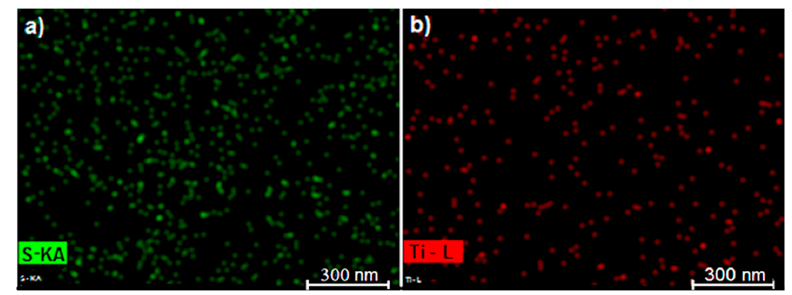
Figure 7. EDX maps for S ( a ) and Ti( b ) for a sample of S–TiO 2 .